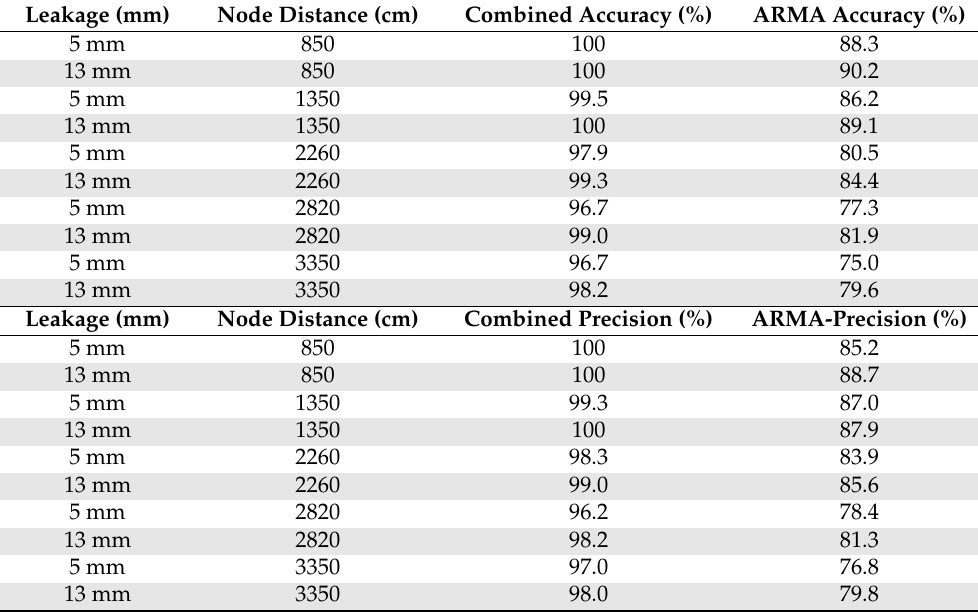
Table 7. Leakage detection performance from oil refinery trials of the (a) proposed combined model, (b) ARMA